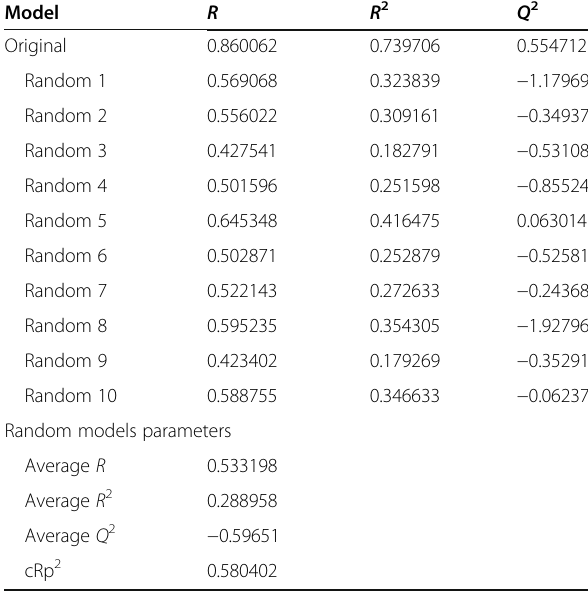
Table 5 Y randomization